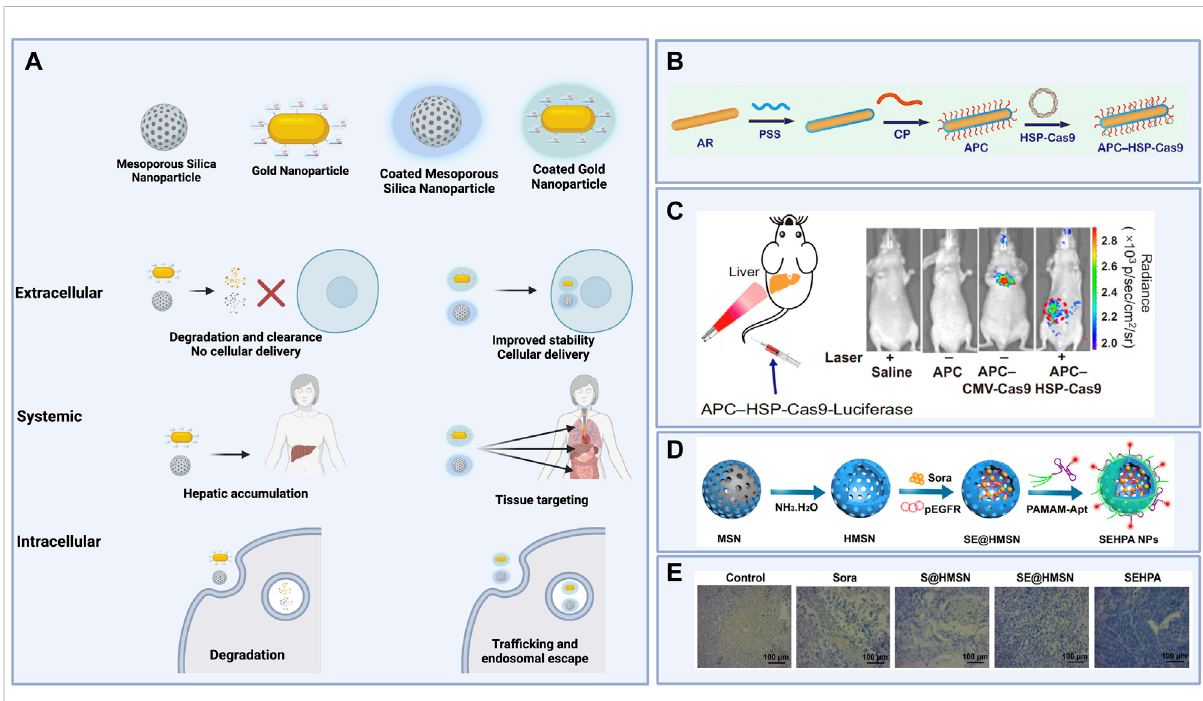
FIGURE 4 (A) Schematic illustrating extracellular, systemic, and intracellular effects of organic coatings for inorganic nanoparticle cores carrying gene editingcargoes. (B) Polystyrenesulfonate(PSS)-and β -cyclodextrin-polyethyleneimine(CD-PEI)-coatedgoldnanorods(APCs)thencomplexedtoa Cas9 plasmid construct with a heat-inducible promoter for spatiotemporal control of gene editing induced by laser irradiation. (C) Luciferase expression after laser irradiation of the liver in mice treated with APCs carrying Cas9 plasmid constructs without a heat-inducible promoter (APC-CMV-Cas9) versus APCs carrying Cas9 plasmid constructs with a heat-inducible promoter (APC-HSP-Cas9). (D) Synthesis of hollow mesoporous silica nanoparticles (HMSNs) loaded with Sorafenib and Cas9 plasmids targeting the EGFR locus, then coated with poly